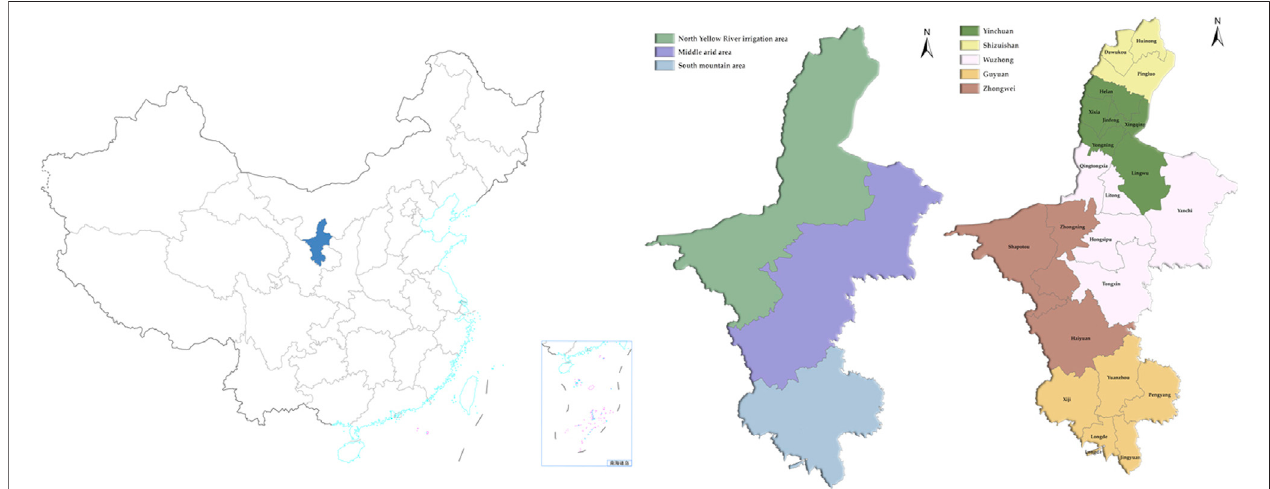
FIGURE 1 | The location of